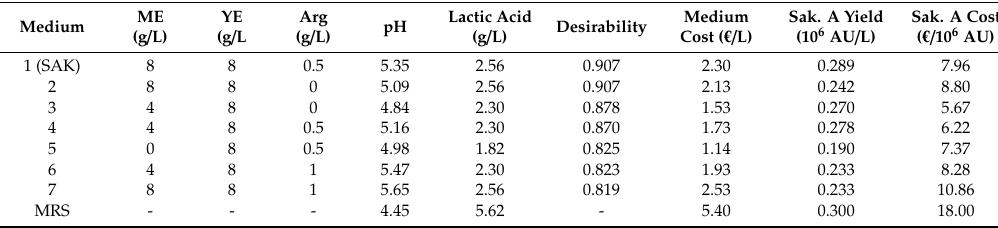
Table 6. Media formulations calculated by the optimization process (Design Expert ® , desirability > 0.800), maximizing lactic acid and sakacin A production: estimated cost of formulation ( € / L), sakacin A production yield (10 6 AU / L) and cost ( € / 10 6 AU) reported and compared with those obtained with MRS (benchmark). Medium Sak. A Yield Sak. A Cost Lactic Acid ME YE Arg pH Desirability Medium Cost ( € / L) (10 6 AU / L) ( € / 10 6 (g / L) (g / L) (g / L (g / L)